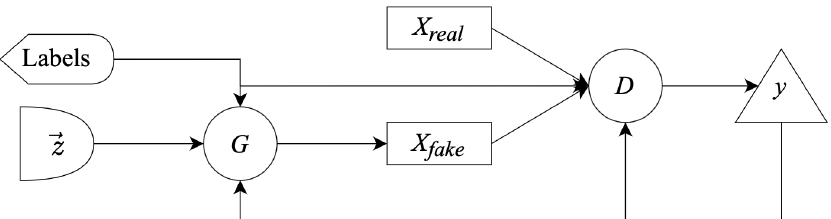
Figure 10. A diagram of a CGAN. The CGAN is similar to a vanilla GAN (see Figure 8), but the generator, G, and the discriminator, D, are conditioned on class